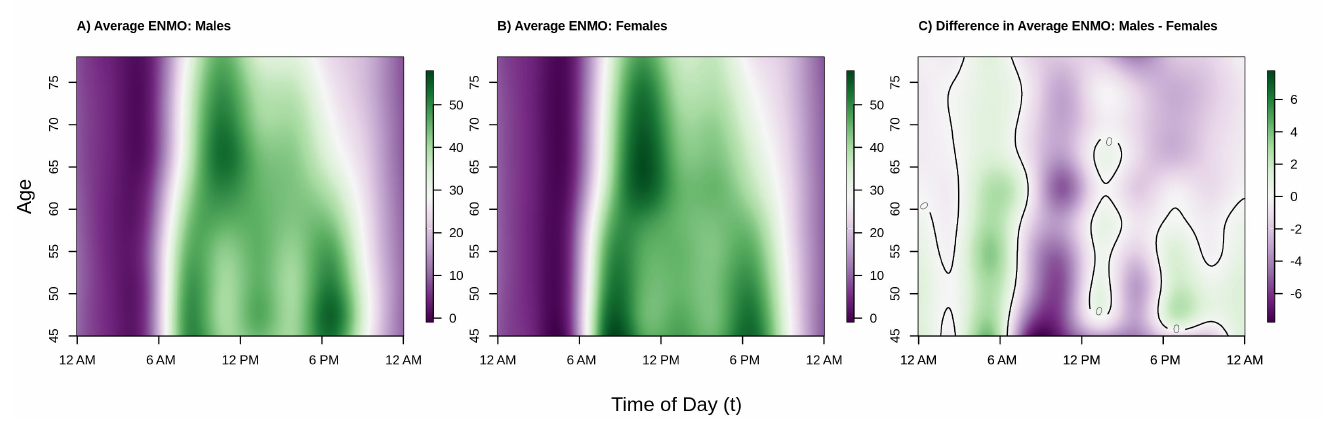
Figure 2. Estimated population average acceleration (ENMO) by age and time of day for Males ( panel A ), Females ( panel B ), and the estimated difference between Males and Females ( panel C ). Color intensity in panels A/B indicates lower (purple) versus higher (green) levels of activity. Color intensity in panel C indicates Males are less (purple), the same (white), or more (green) active as compared to Females, with a solid black line demarcating the transitions between regions where males are more or less active than females (i.e., the difference is 0). Estimates of these surfaces in panels A/B are obtained by fitting a function-on-scalar regression (FoSR) model separately by sex where the population average ENMO is allowed to vary smoothly in both time of day and age. The FoSR model is fit by modelling the average ENMO as a tensor product smooth of marginal spline bases, with cyclic cubic regression splines used in the time domain to respect the cyclic nature of time. Panel C is obtained by taking the difference of panels A and